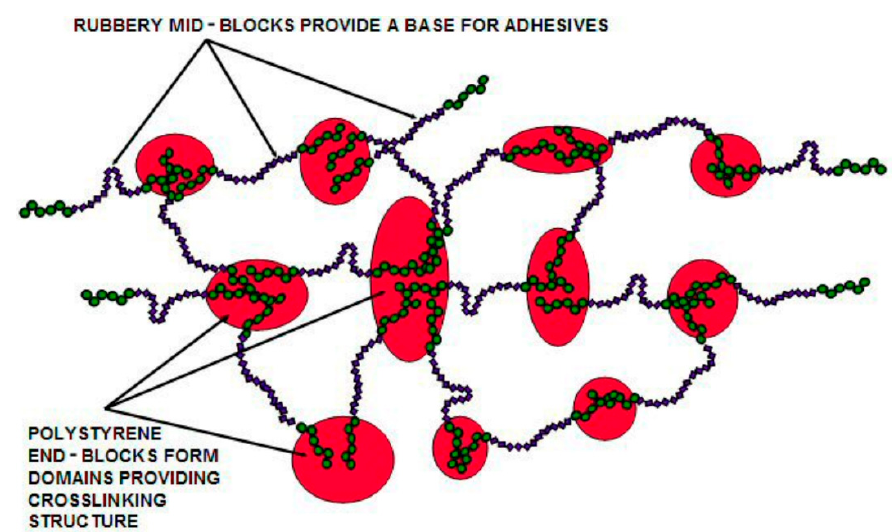
Figure 5. Schematic representation of styrene-butadiene block copolymer morphology (reprinted from [62]).